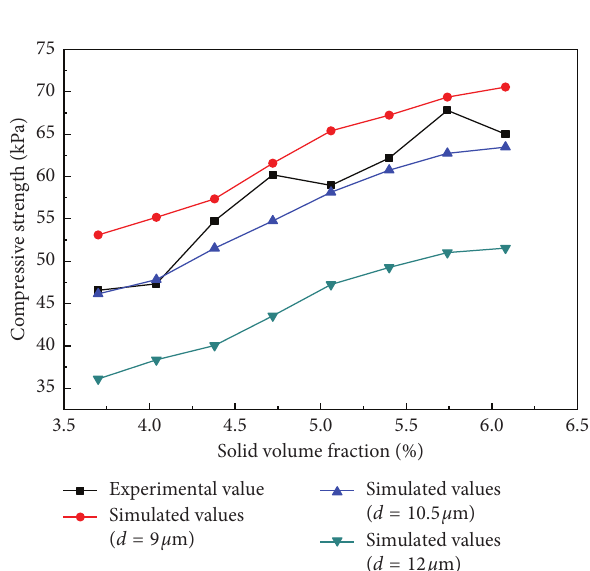
Figure 6: Relationship between the measured values of compressive strength and numerical calculation results of different SVF